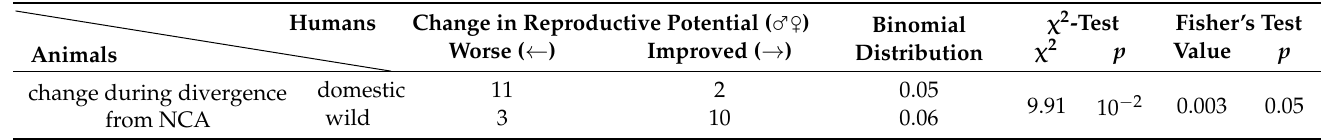
Table 3. Correlations between the effects of the co-directed changes in the expression of orthologous genes on human reproductive potential and on the divergence of the guinea pig and cavy from their NCA.